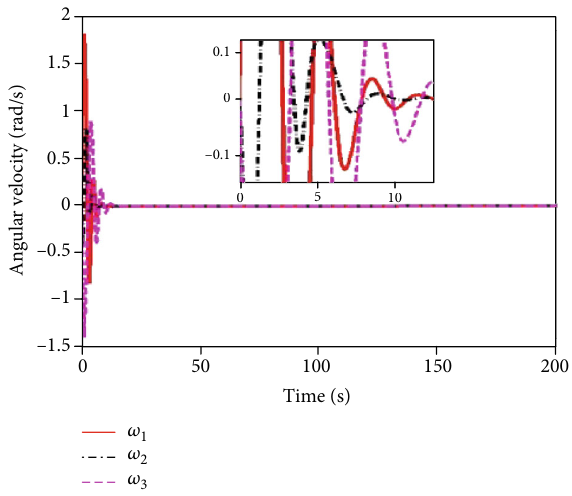
Figure 23: Time histories of angular velocities in Case 3 when k ð 0 Þ = 10 .